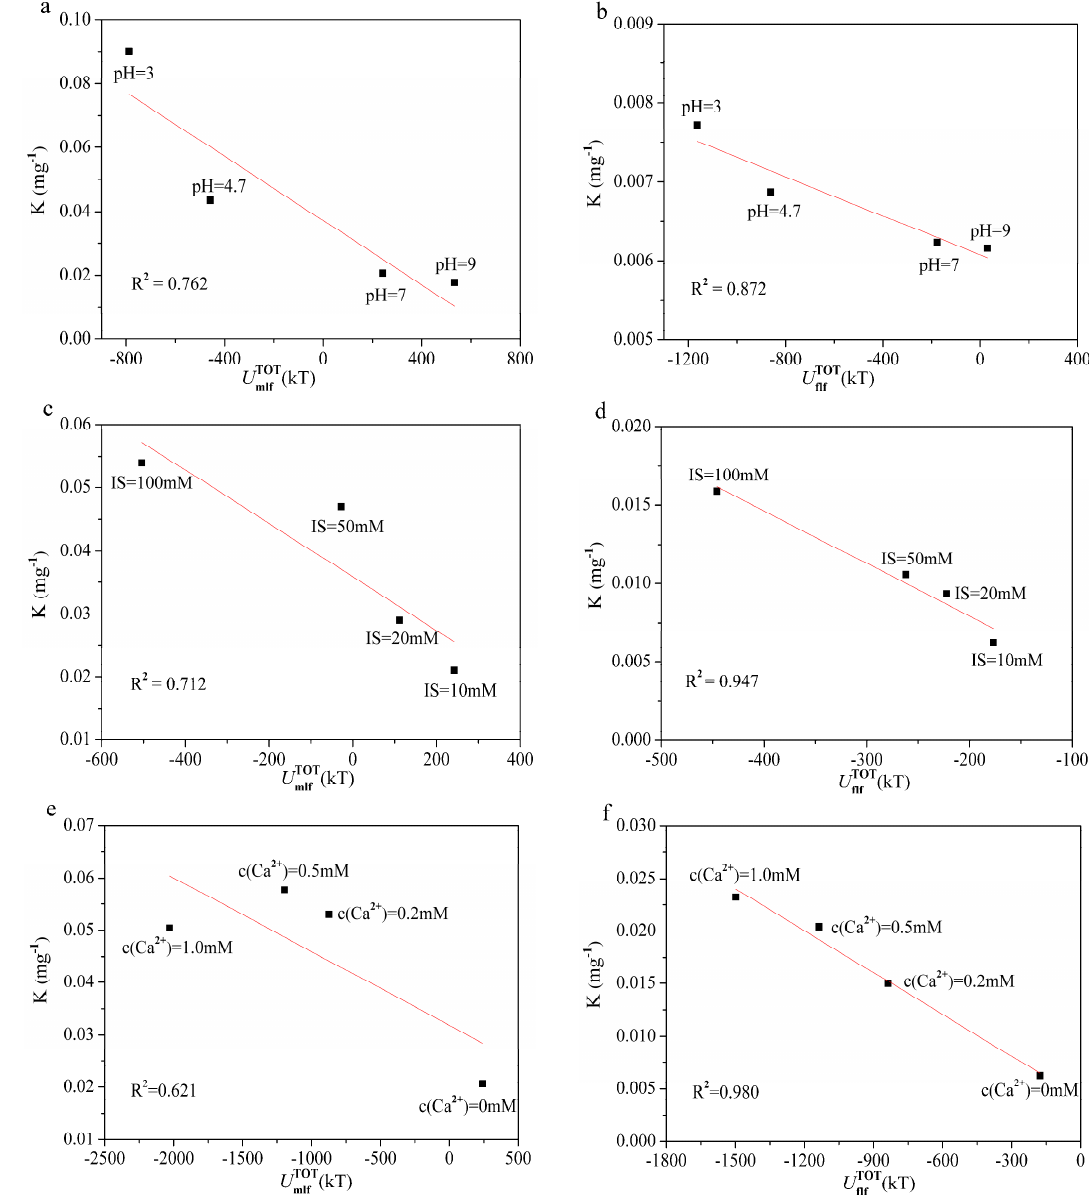
Figure 4. The correlation analysis between interaction energies and fouling potentials at initial and final stages with different solution conditions: ( a , b ) pH; ( c , d ) IS; ( e , f ) Ca 2+